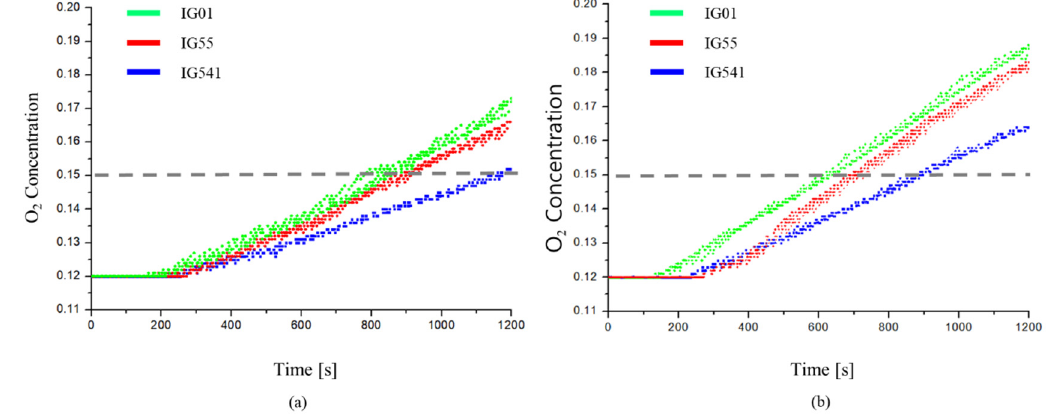
Figure 11. Change in the O 2 concentration over time for each inert agent: ( a ) 8 holes; ( b ) 12 holes.